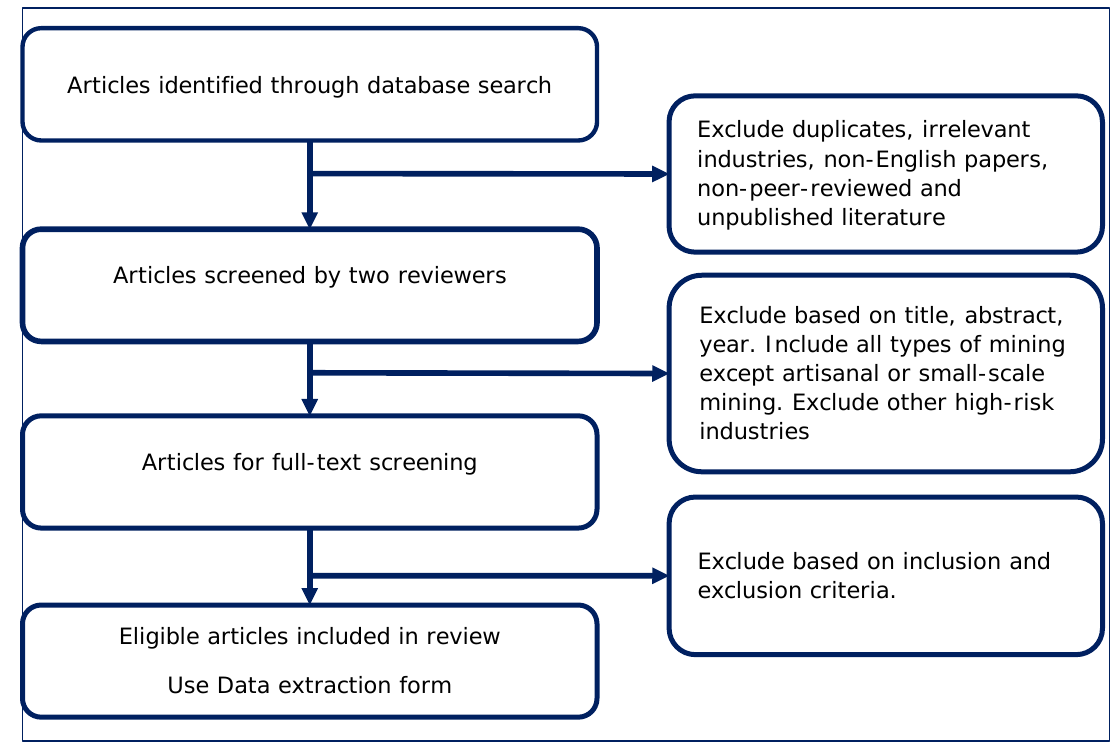
Figure 1. Flowchart for study selection. Adapted from Cornelissen et al. (2017)